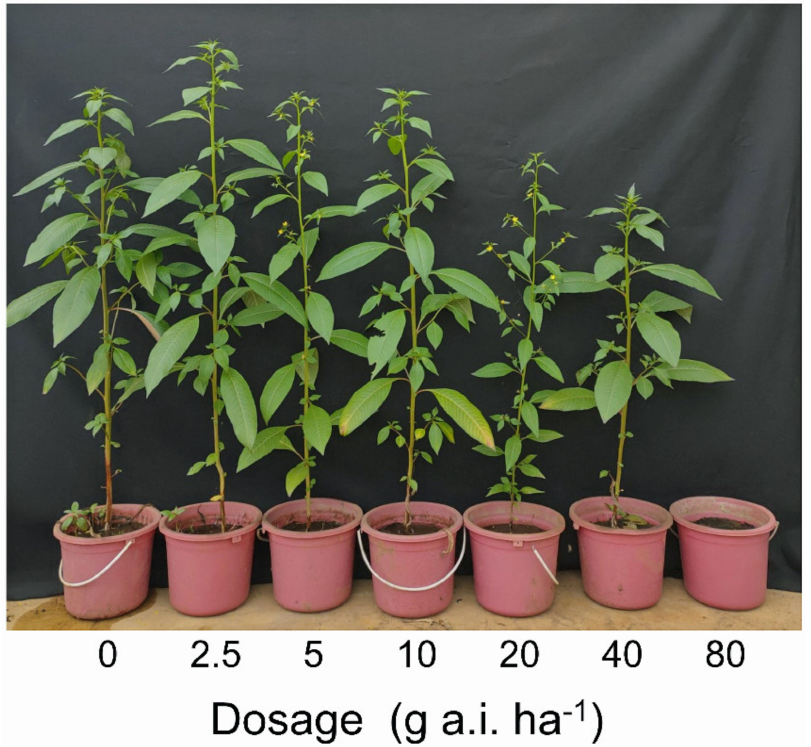
Figure 2. Effect of penoxsulam on the Demakan population of L. decurrens 56 days after herbicide